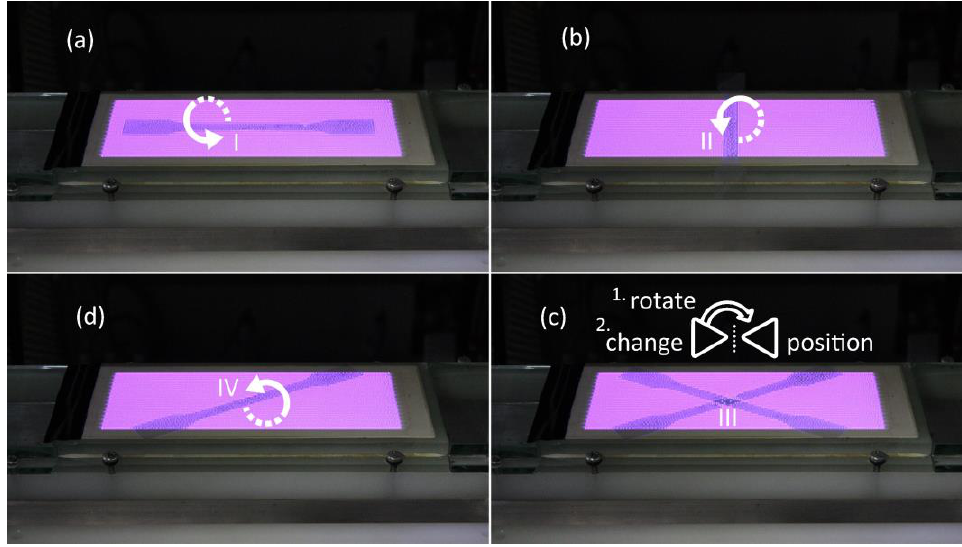
Figure 1 . Side view of the plasma treatment films of PVC type ( a ) I, ( b ) II, ( c ) III, ( d ) IV.